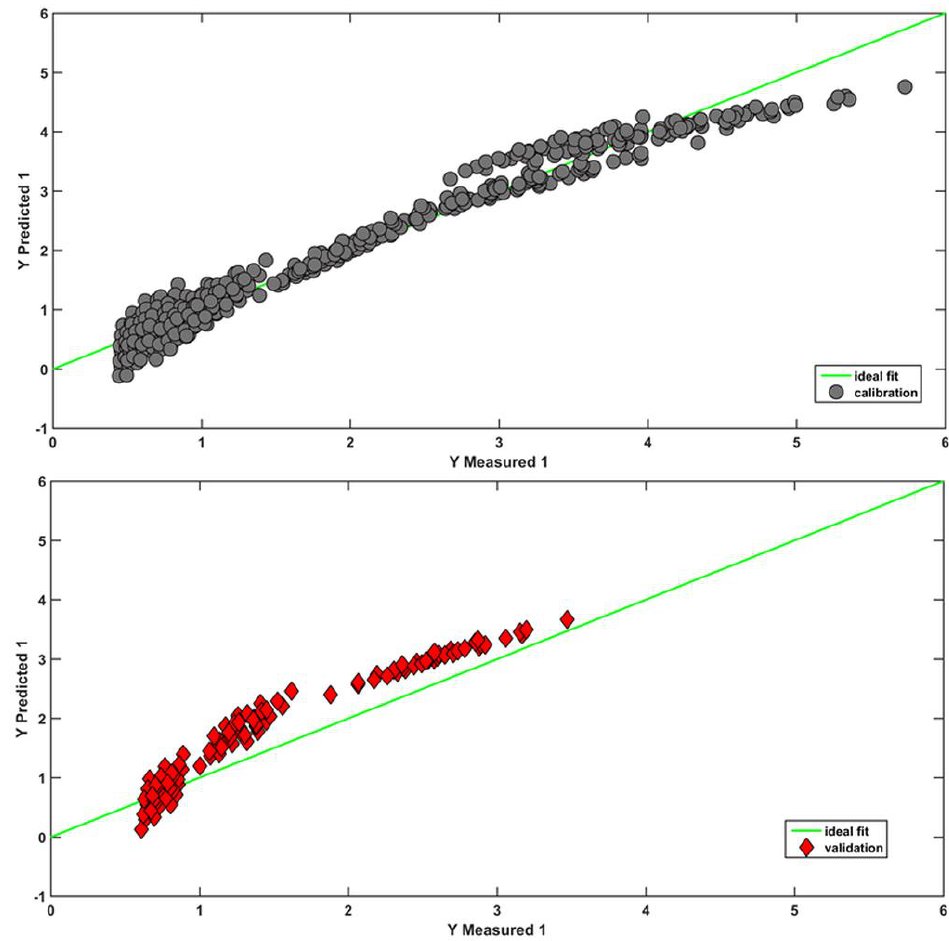
Figure 3. PLS model on the predictors selected by CovSel.